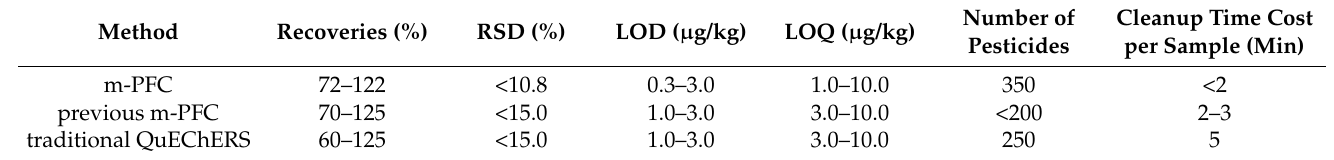
Table 1. Comparison of the proposed method with other